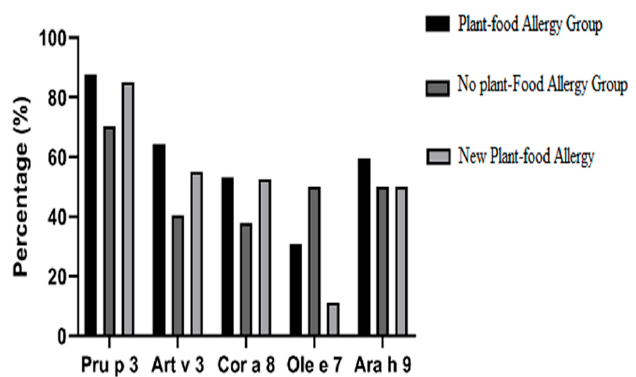
Figure 2. Percentage of sensitization to several nsLTPs in different groups of patients.